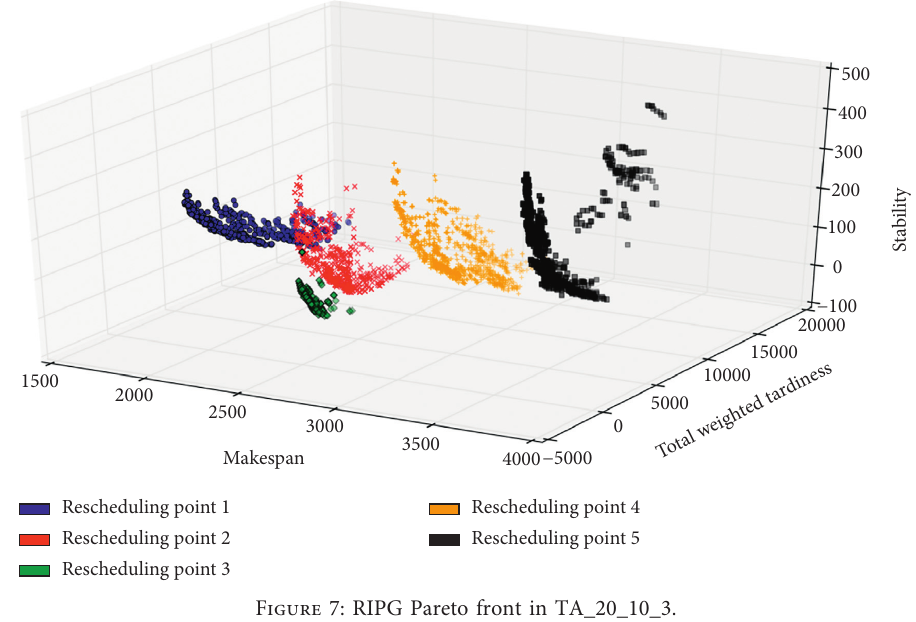
Figure 7: RIPG Pareto front in